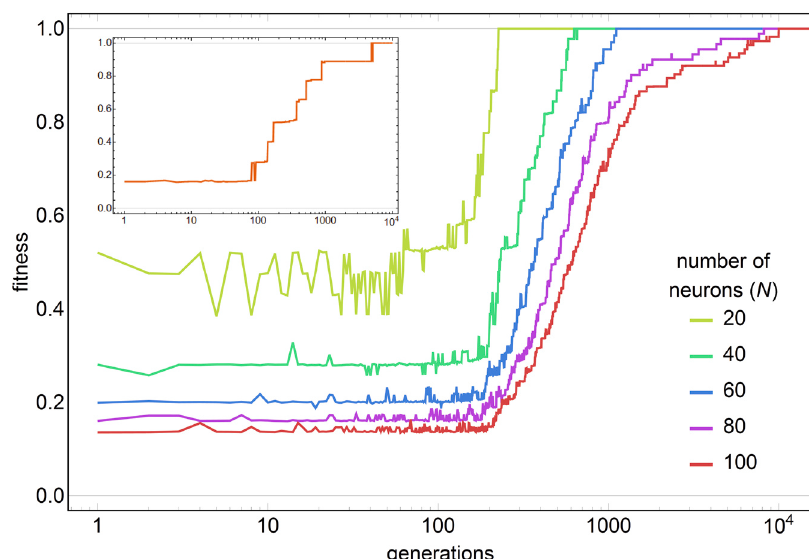
Figure 5. Convergence of the actual best fitness of the metapopulation with increasing problem size N on general building block function landscape. Each curve is an average of 10 independent iterations. N network, patterns of length N are partitioned to blocks of size P = 10 ( B = N / P blocks per pattern), p Note the logarithmic x axis. Inset: single simulation at N = 80, B = 8 (other parameters are the same). Plateaus roughly correspond to more and more blocks being optimized by finding the best subsequence on the building-block fitness